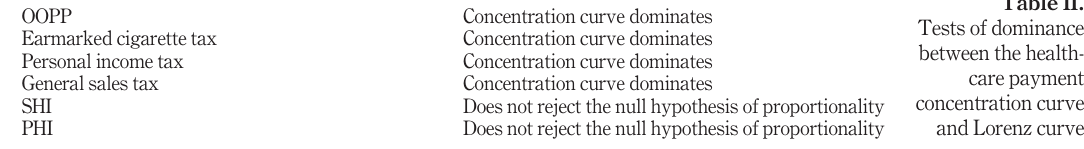
Figure 9. Concentration curve for PHI